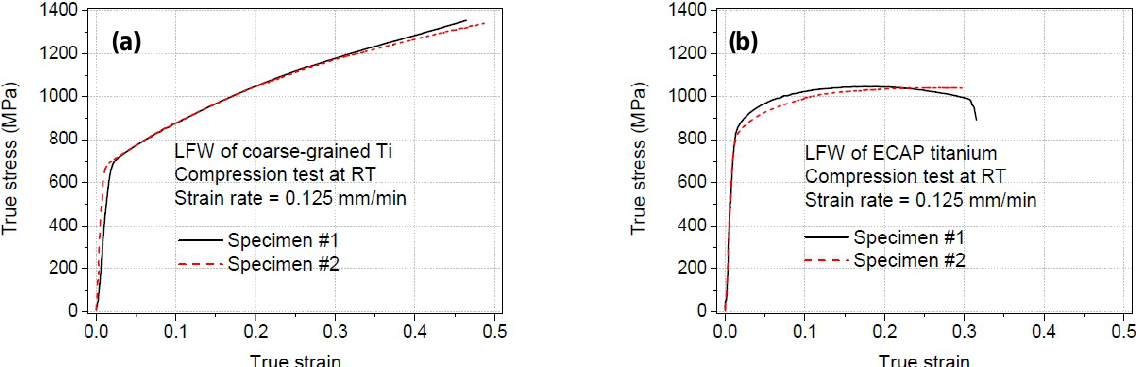
8. Engineering stress-strain curves for coarse-grained and nanostructured LFW samples of titanium tested in compression.